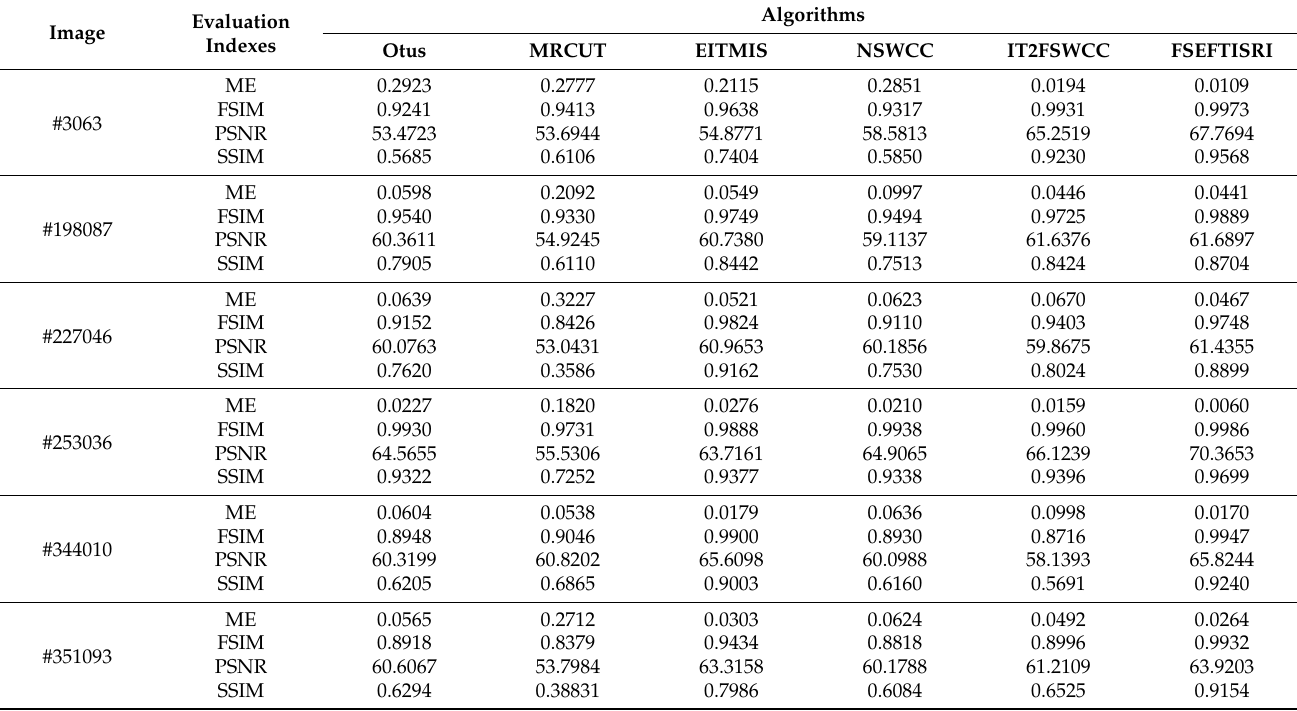
Table 2. Comparison of evaluation indexes of several algorithms in